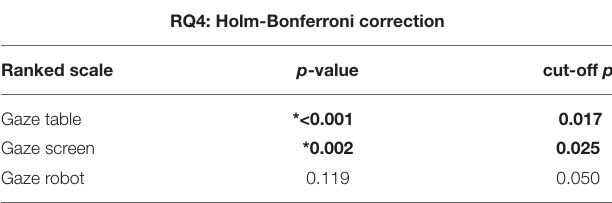
TABLE 8 | Ranked p -values for the follow-up univariate analysis performed for RQ4 with corresponding cut-off p -values due to Holm-Bonferroni correction. RQ4: Holm-Bonferroni correction Ranked